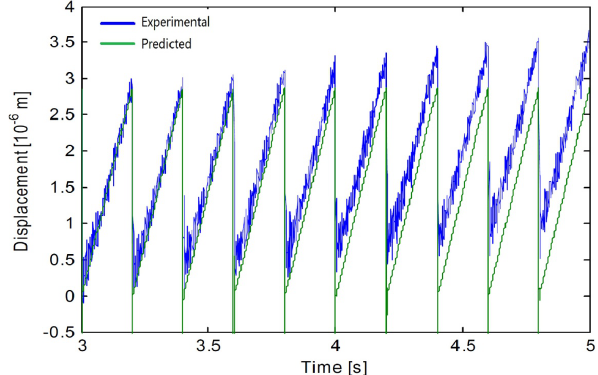
Figure 25. Experimental data and displacement predicted using the elastoplastic model.